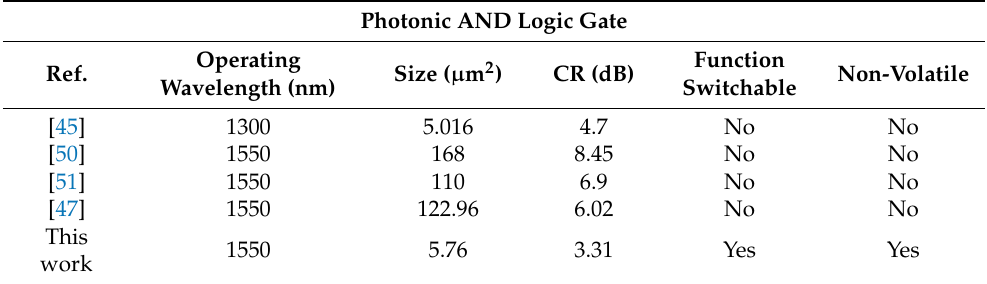
Table 6. Performance comparison between the proposed photonic AND logic gate and several reference structures reported in other papers.